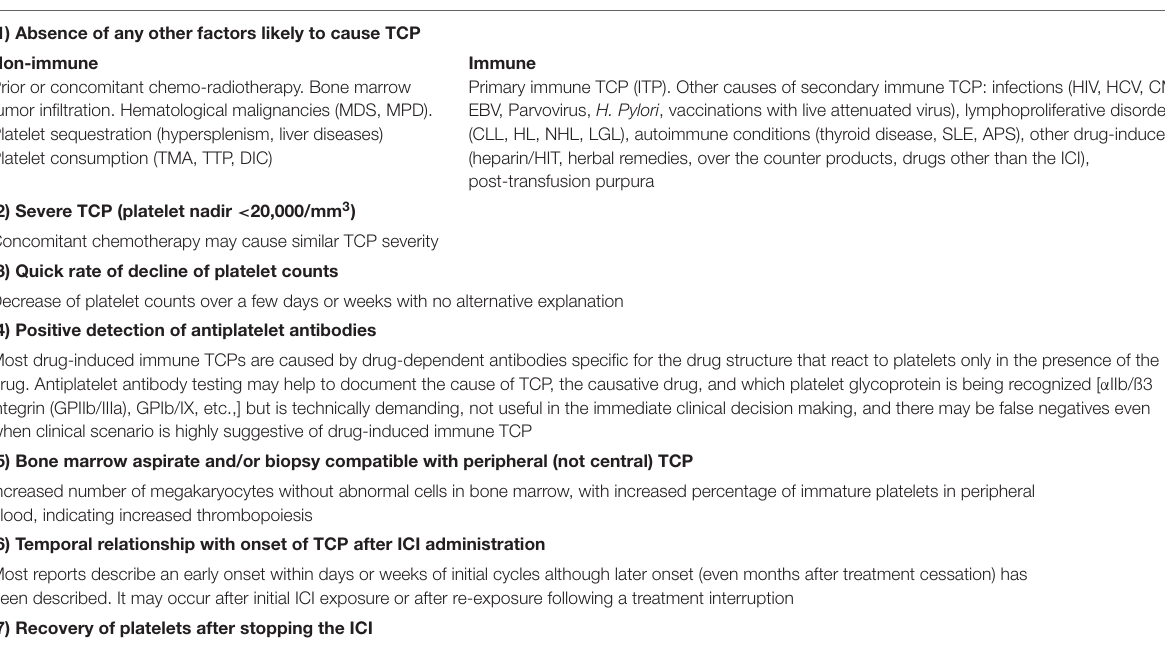
TABLE 1 | Diagnostic criteria suggestive of immune-related